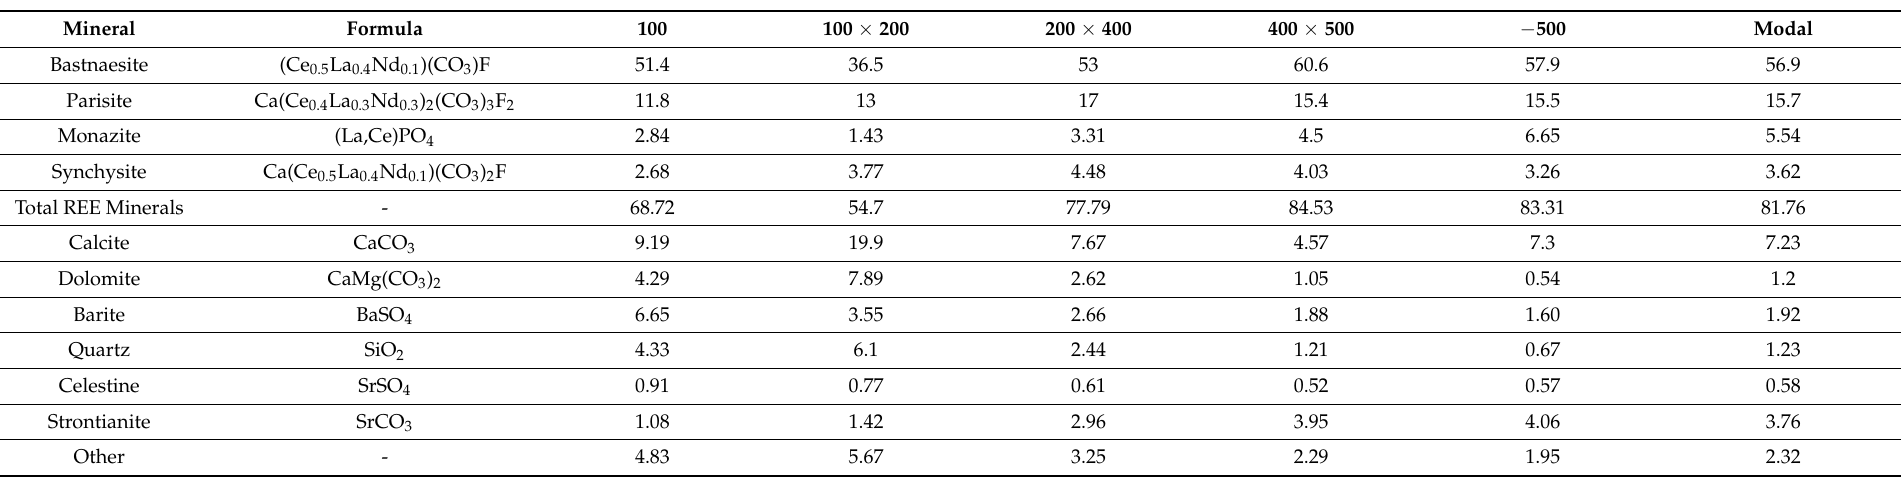
Table 1. Mineral content by size fraction (mesh) for the MPC material MLA specimen.